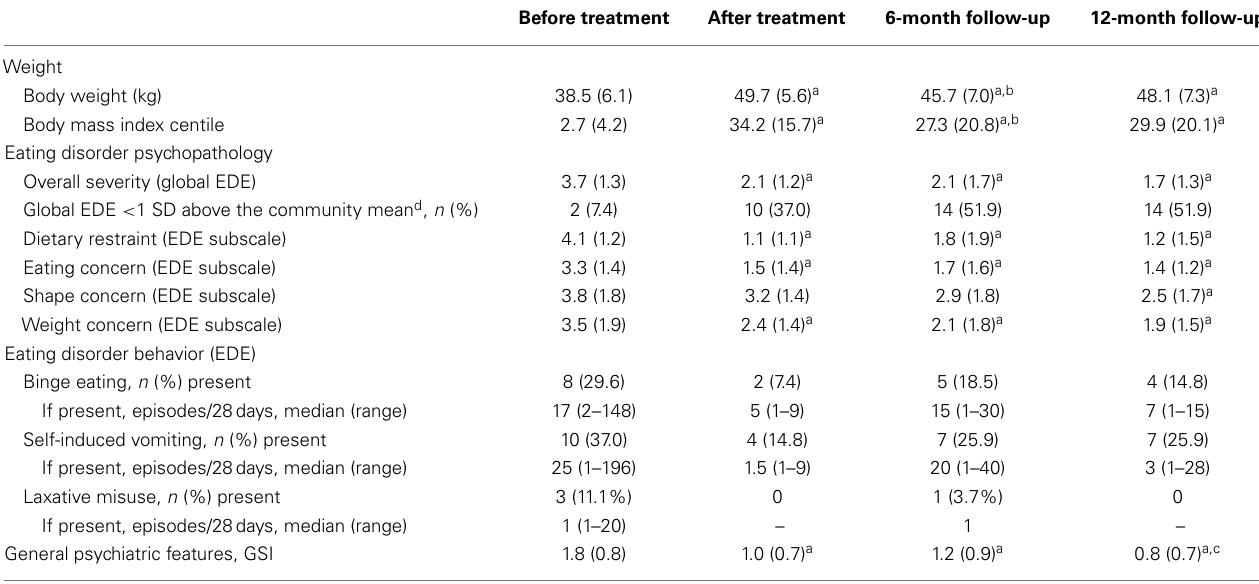
Table 1 | Characteristics of the patients before treatment, after treatment, and at 6- and 12-month follow-up (intent-to-treat data set, n = 27) . Before